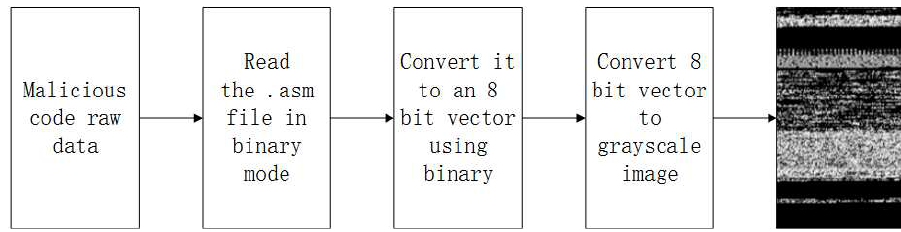
Figure 2. Malicious code visualization